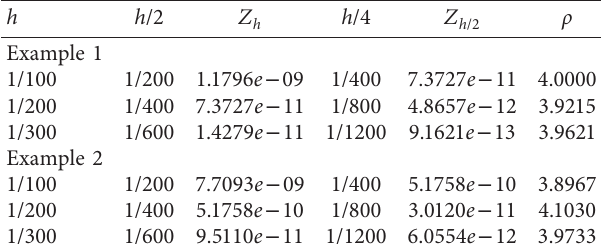
Figure 4: The numerical solution of Example 4 with ε � 0 . 001 and N � 100. Table 7: Rate of convergence ρ for ε � 0 . 1 and δ � 0 . 05 .